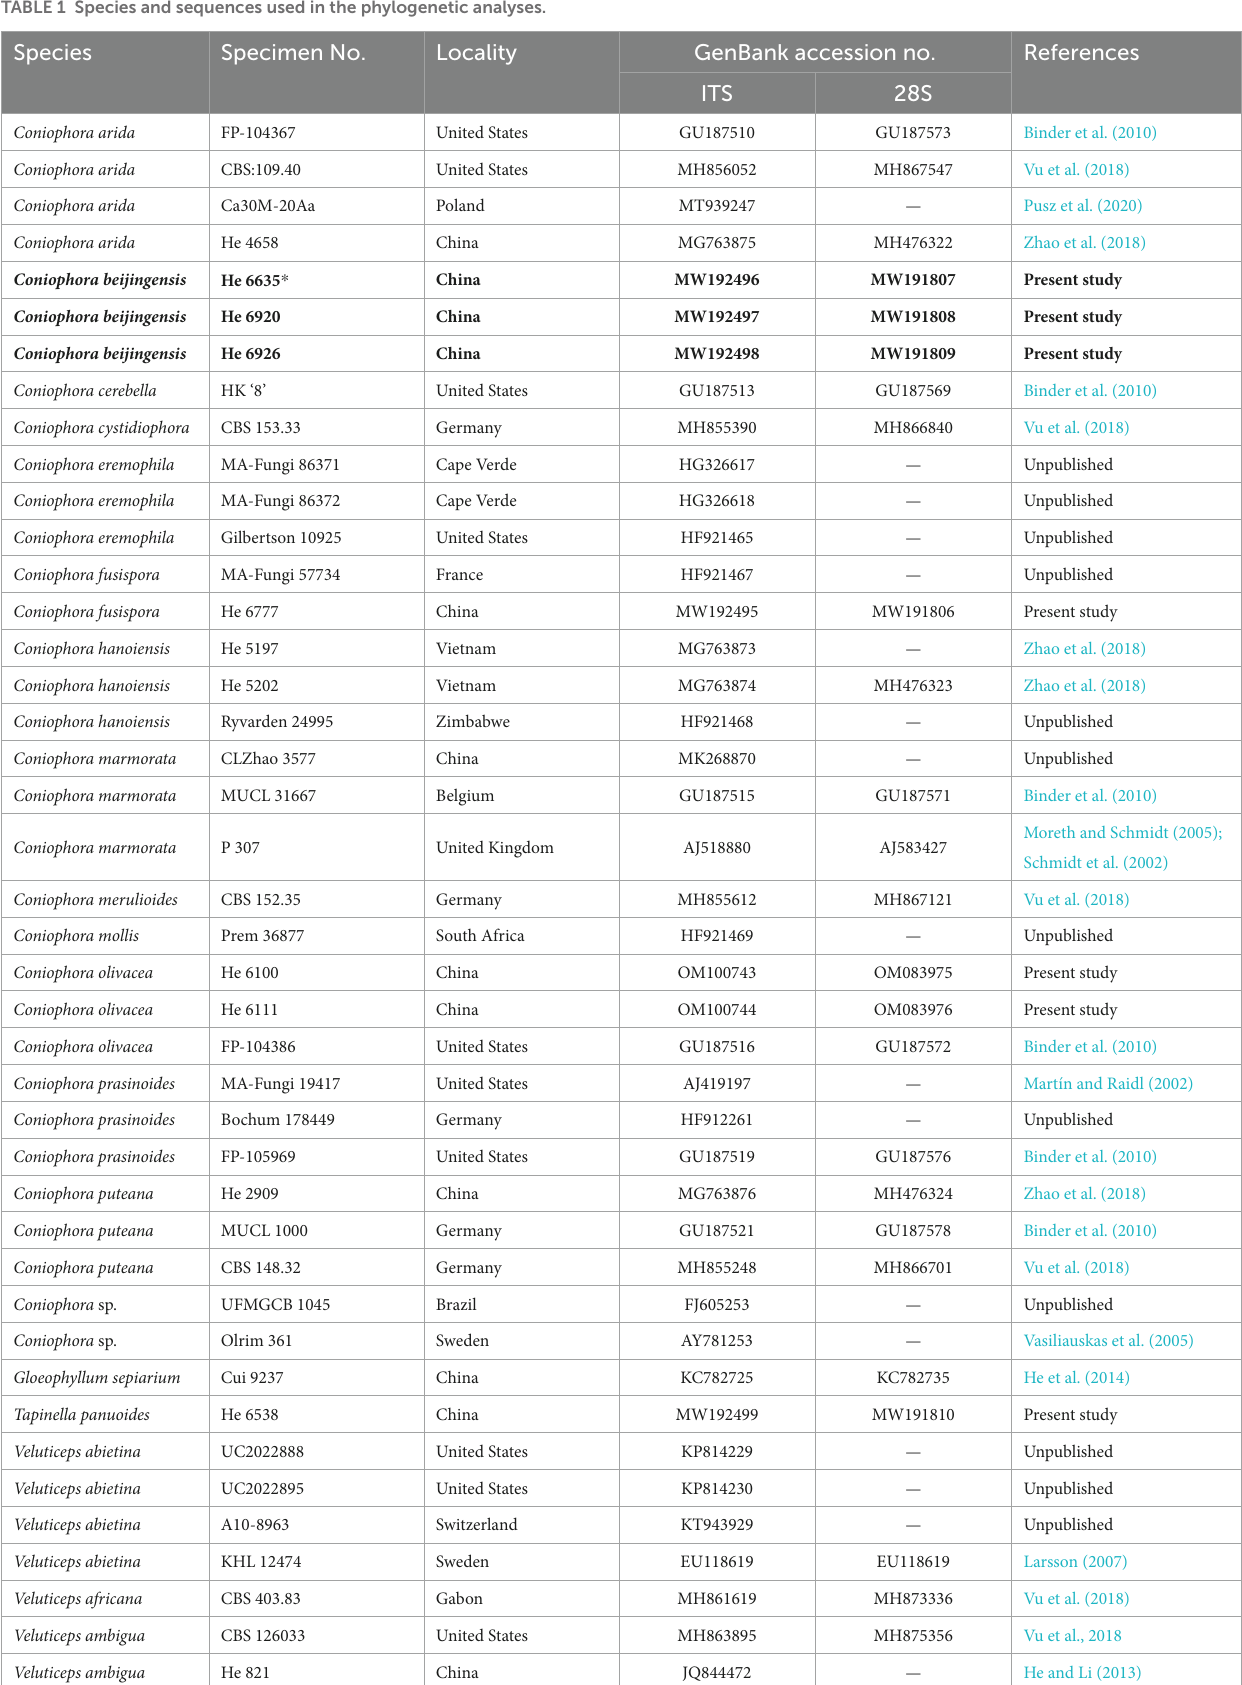
TABLE 1 Species and sequences used in the phylogenetic analyses.